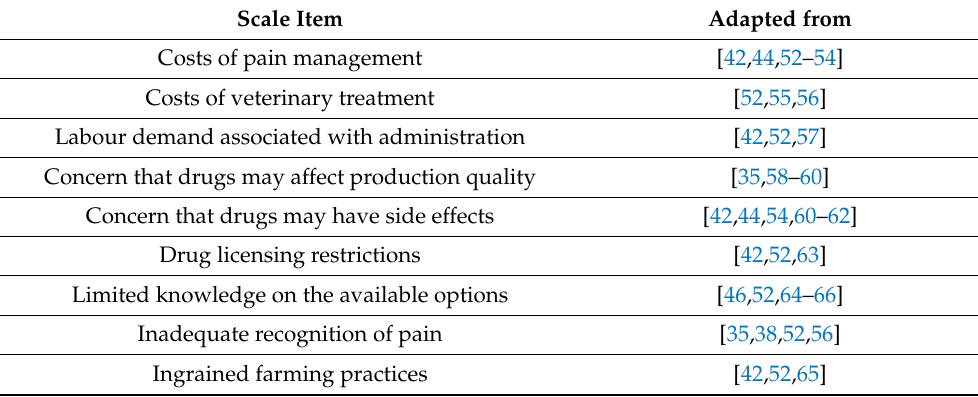
Table 2. Likert-type scale items adapted from the existing literature concerning potential barriers to the provision of pain